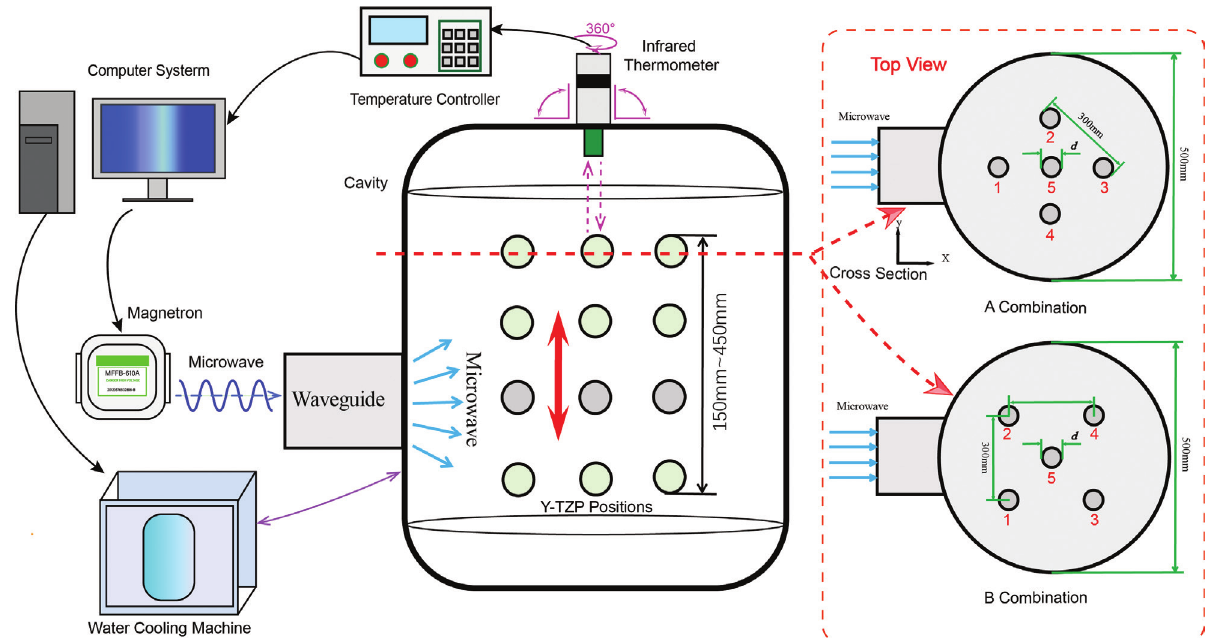
Figure 1: Schematic diagram of the geometric